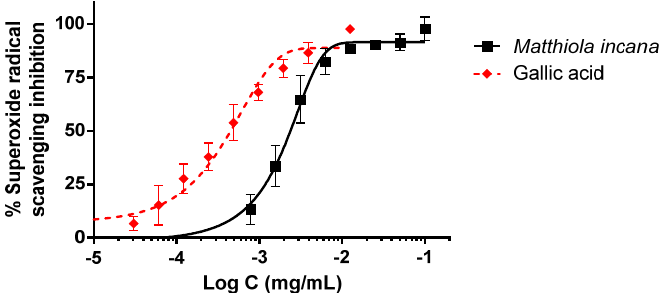
Figure 3. Antioxidant activity of the hydroalcoholic extract of M. incana aerial parts evaluated in the xanthine / xanthine oxidase system. IC 50 values were calculated by non-linear regression. All concentrations were tested at least in triplicate, and each point represents mean ± SEM.